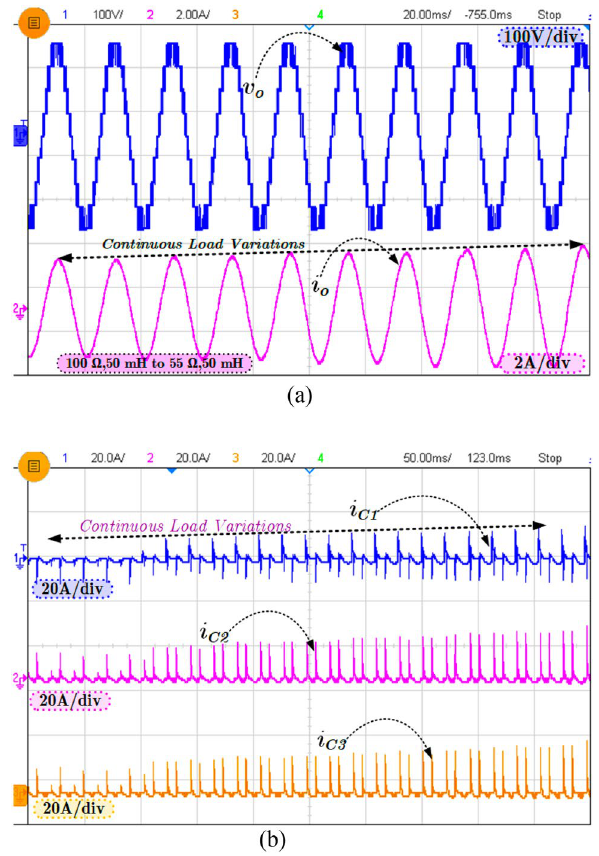
Figure 7. Experimental results ( a ) Continuous load change and ( b ) corresponding capacitors (C 1 –C 3 ) current.